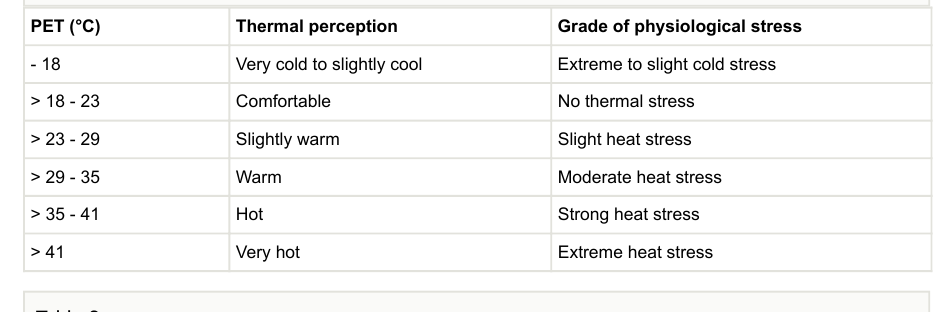
Ranges of physiological equivalent temperature (PET) for different grades of thermal perception, adapted from Matzarakis et al. (1999).